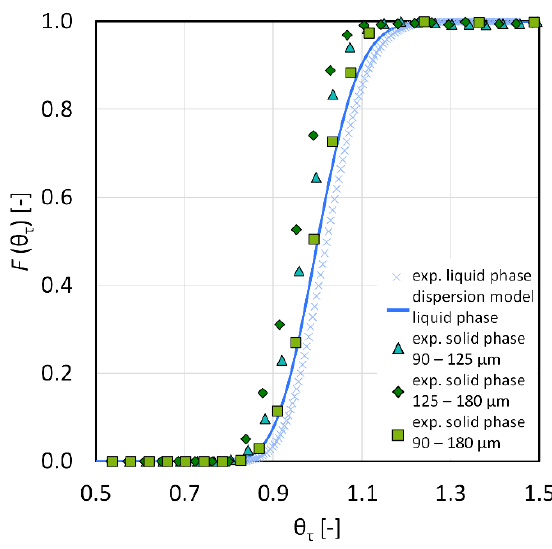
Figure 4. Residence time distribution for four CUs of the CFIC for different phases (single experi- ments). Table 2. Averaged (over 3 experiments) residence time and characteristic process